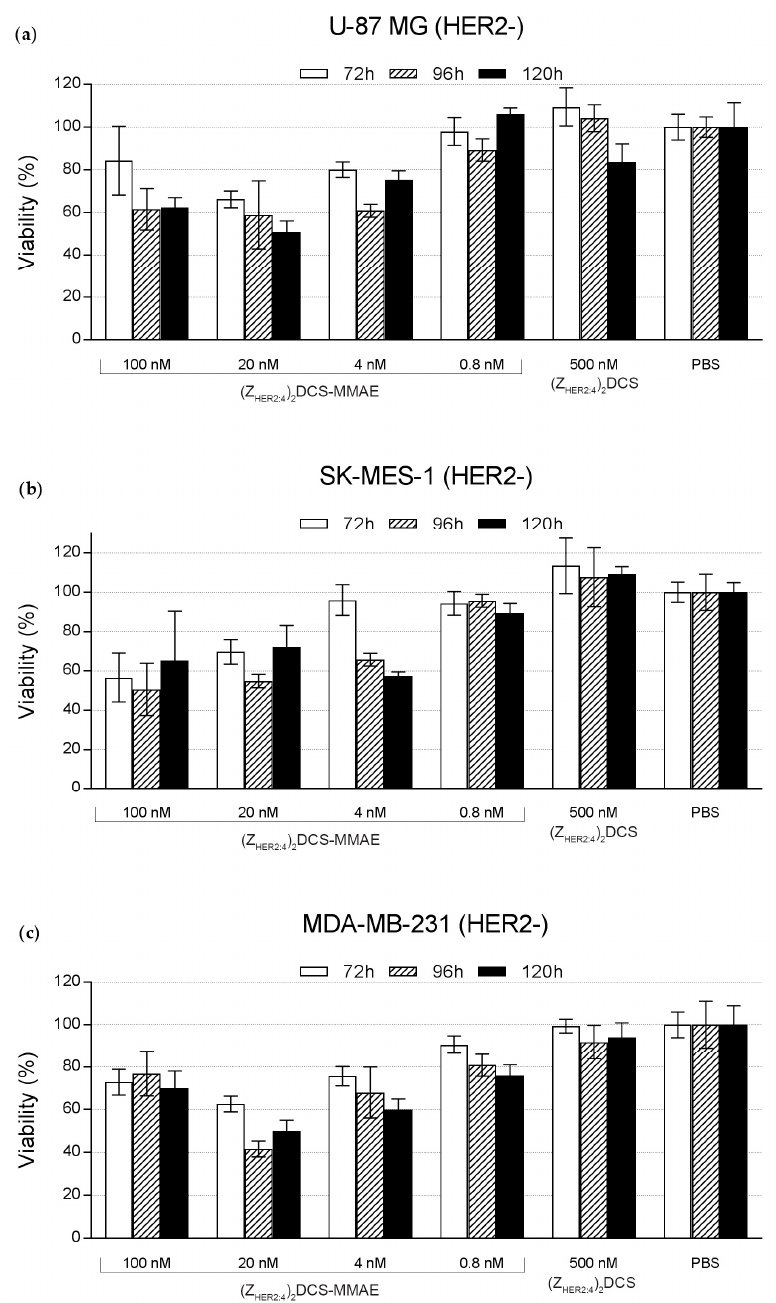
Figure 10. Viability assay results for the three HER2-negative cell lines ( a ) U-87 MG (human brain cancer); ( b ) SK-MES-1 (human lung cancer); and ( c ) MDA-MB-231 (human breast cancer). These cells were incubated with the indicated doses of (Z HER2:4 ) 2 DCS-MMAE, 500 nM MMAE, and 500 nM (Z HER2:4 ) 2 DCS. Cell viability was assessed after 72, 96, and 120 h incubation. The error bars show the standard deviation.